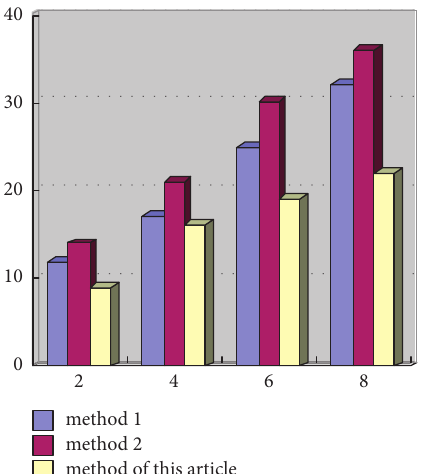
Figure 10: Comparison of picking efficiency of different